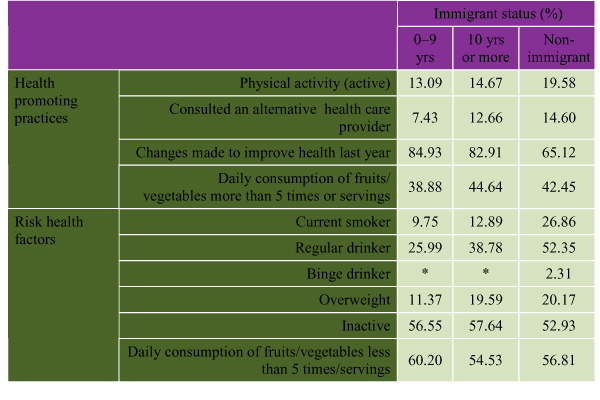
Immigrant Status and Health Practices (not age-adjusted) Source: Statistics Canada, CCHS, 2000–2001.* Insufficient sample size to report